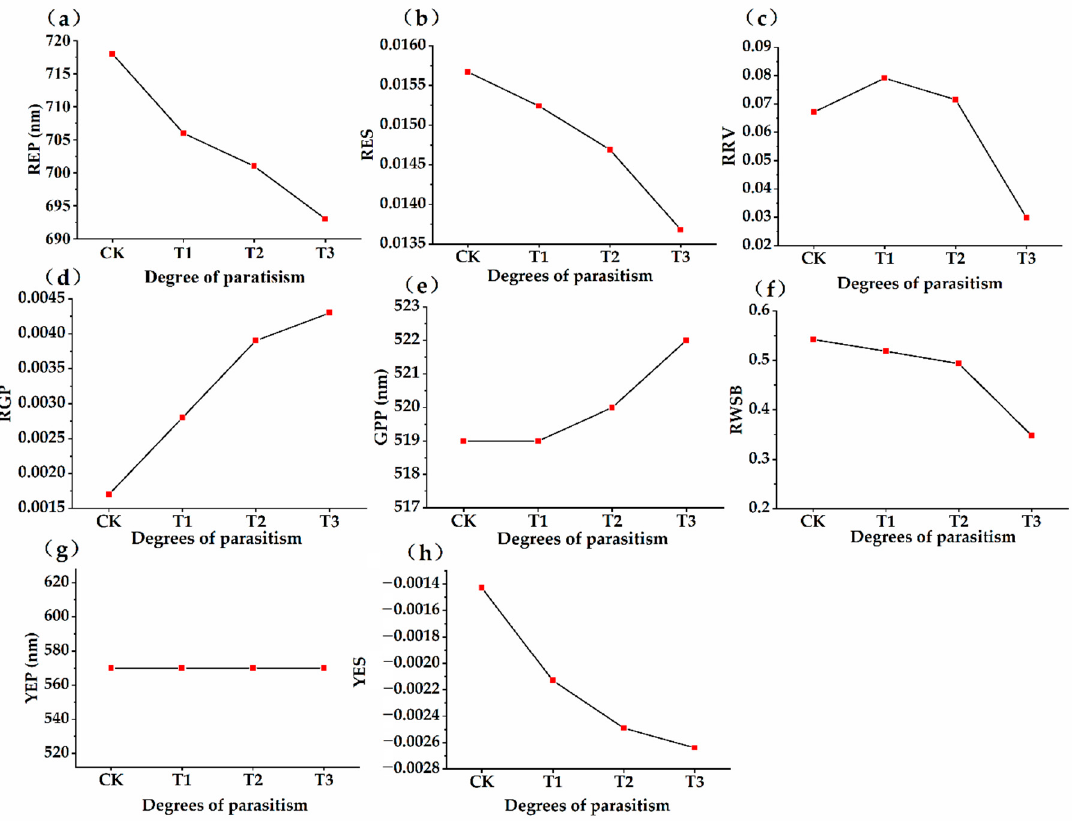
Figure 6. Dynamic trend of spectral parameters in different parasitism period. ( a – h ) respectively represents the position of red edge (REP), the slope of red edge (RES), the reflectance of red valley (RRV), the reflectance of green peak (RGP), the position of green peak (GPP), the reflection of water stress band (RWSB), the position of yellow edge (YEP), and the slope yellow edge (YES) under different parasitic intensities.